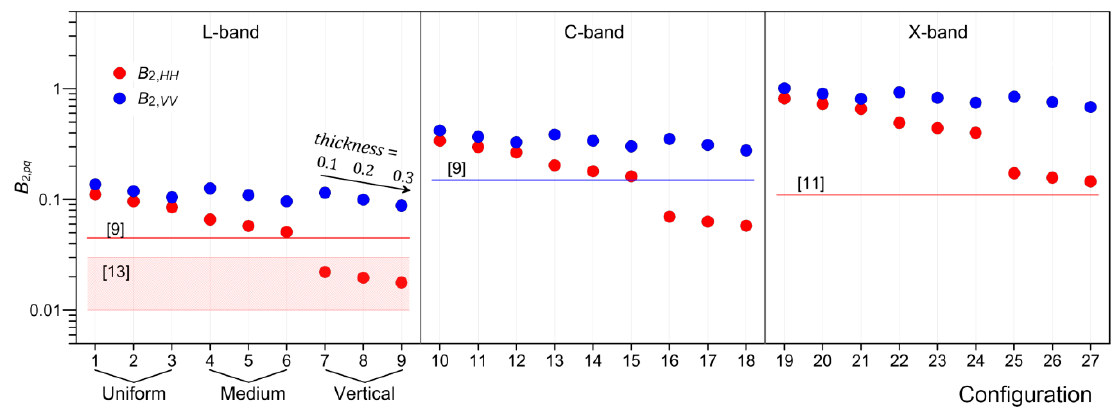
Figure 9. Variations of the B 2, HH (red circle) and B 2, VV (blue circle) parameters estimated for di ff erent simulation configurations. The blue and red lines represent B 2, HH and B 2, HH values, respectively, reported in the literature.